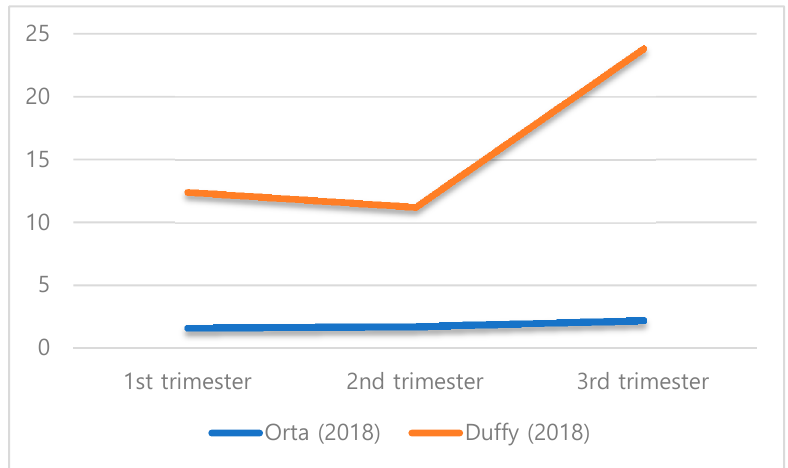
Figure 2. Variation of hair cortisol concentrations per trimester of pregnancy. Table 3. Laboratory analysis of hair samples.